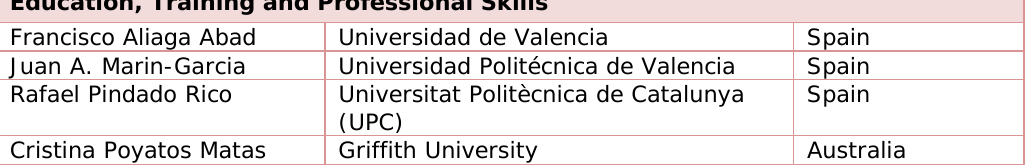
Table 1. “Members of the editorial board during 2008”